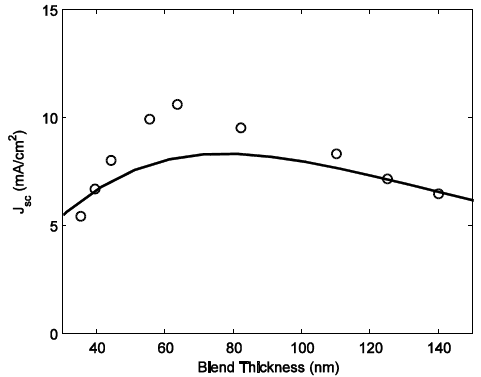
Figure 7. Short circuit current density ( J sc ) versus active layer thickness ( L ). Symbols: experimental data and solid line: model fit to the experimental results. and solid line: model fit to the experimental results.